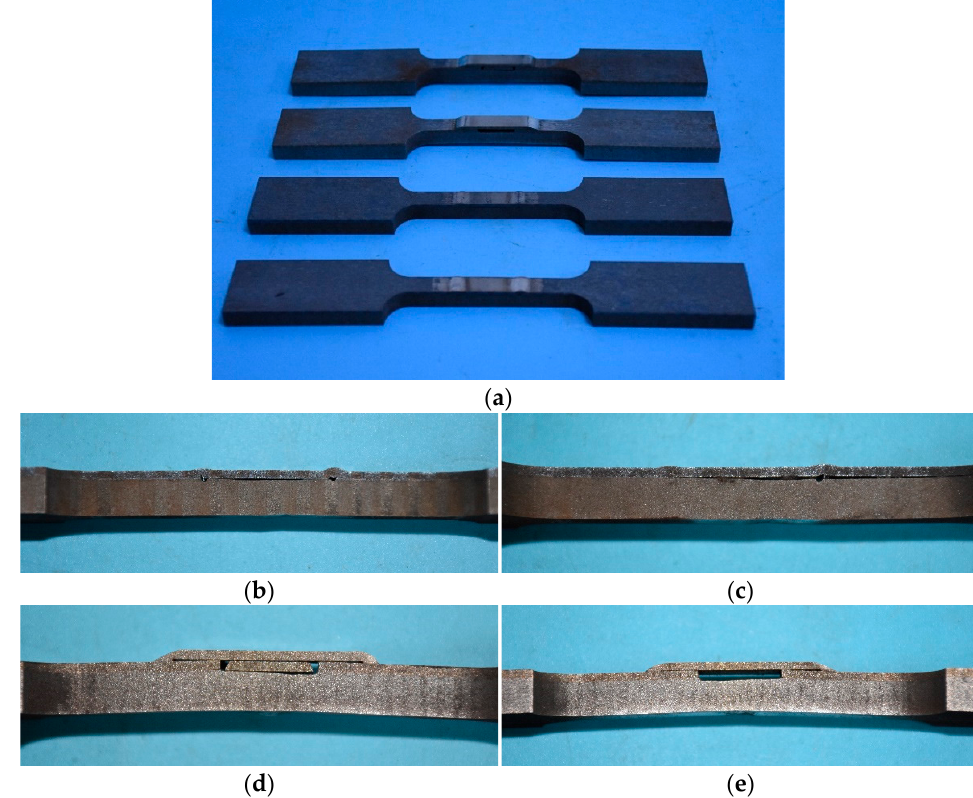
Figure 7. Photos of test coupons of TC bimetallic steel welded joints. ( a ) Test coupons of welded joints, ( b ) Type II welded joints, ( c ) Type II welded joints with initial bonding interface damage, ( d ) Type III welded joints with filler plate and ( e ) Type III welded joints without filler plate. Table 8. Measured geometric dimensions of different coupons.